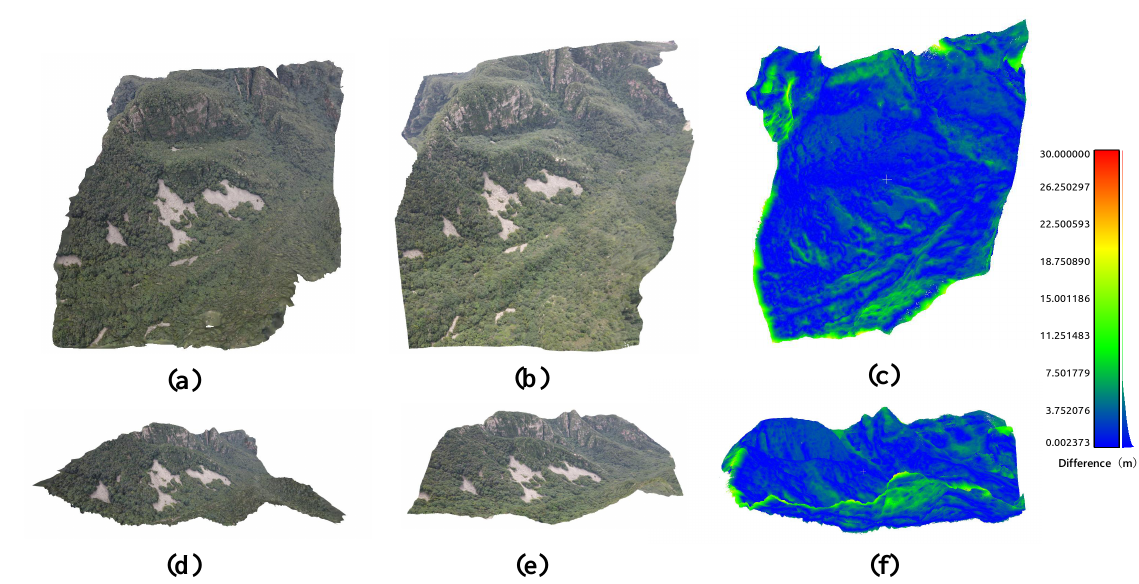
Figure 16. The image sequence data is Mountains-2 in Table 3. Reconstruction results compared with Photoscan. ( a , d ) are the top view and the front view of the model generated by Photoscan offline. ( b , e ) are the corresponding results generated by our real-time approach. ( c , f ) are the difference pseudo-color image.